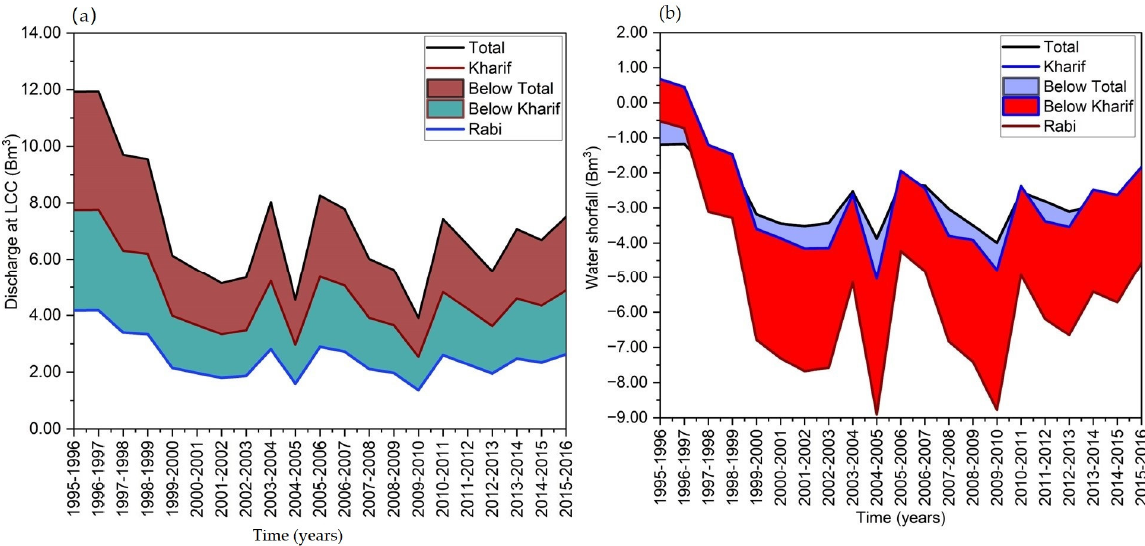
Figure 8. ( a ) Temporal variation in surface water availability, and ( b ) cumulative deficit estimated in Rabi and Kharif season.